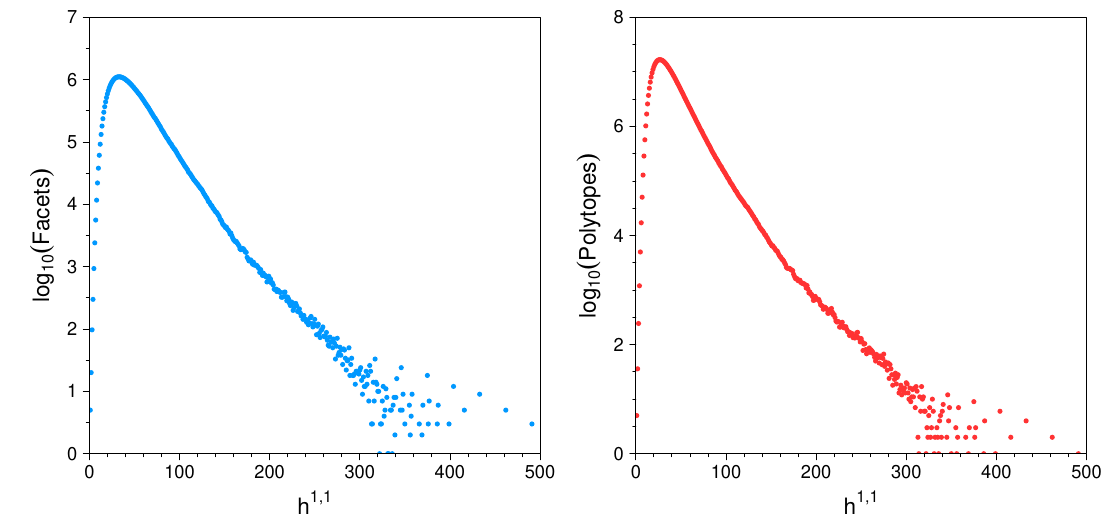
Figure 1 . (Left) The logarithm of the number of new facets at each h 1 ; 1 value. (Right)